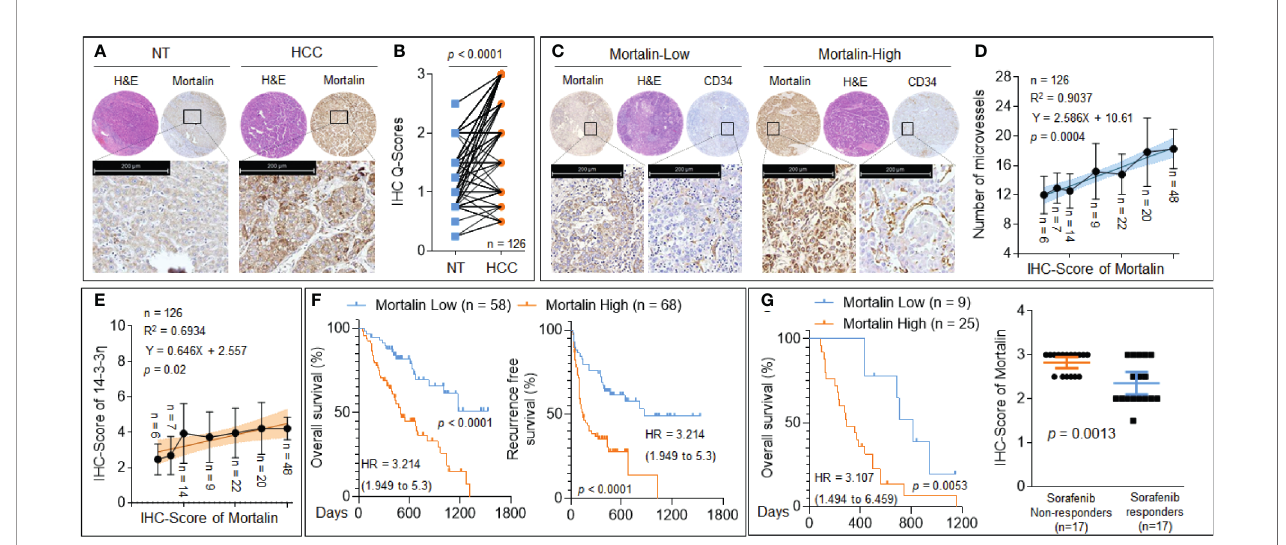
FIGURE 5 | The clinical signi fi cance of mortalin in hepatocellular carcinoma (HCC). (A, B) Tissue microarray and immunohistochemistry (IHC) analyses of mortalin in samples from patients with HCC compared with adjacent non-tumor liver tissues. (C) Tissue microarray and IHC analyses of mortalin and CD34 in HCC samples. (D) Relationship between the expression of mortalin and the number of microvessels. (E) Triplicate tissue microarray and IHC analyses of mortalin and 14-3-3 h in HCC sample; their relationship is exhibited. (F) Kaplan – Meier analyses of the prognostic signi fi cance of mortalin in 126 patients with HCC. ( G , left) Kaplan – Meier analyses of the prognostic signi fi cance of mortalin in 34 patients with advanced recurrent HCC. ( G , right) Analyses of the mortalin levels in sorafenib nonresponders and sorafenib responders. IHC staining was performed in triplicate. The differences were analyzed using Student ’ s t -test and linear